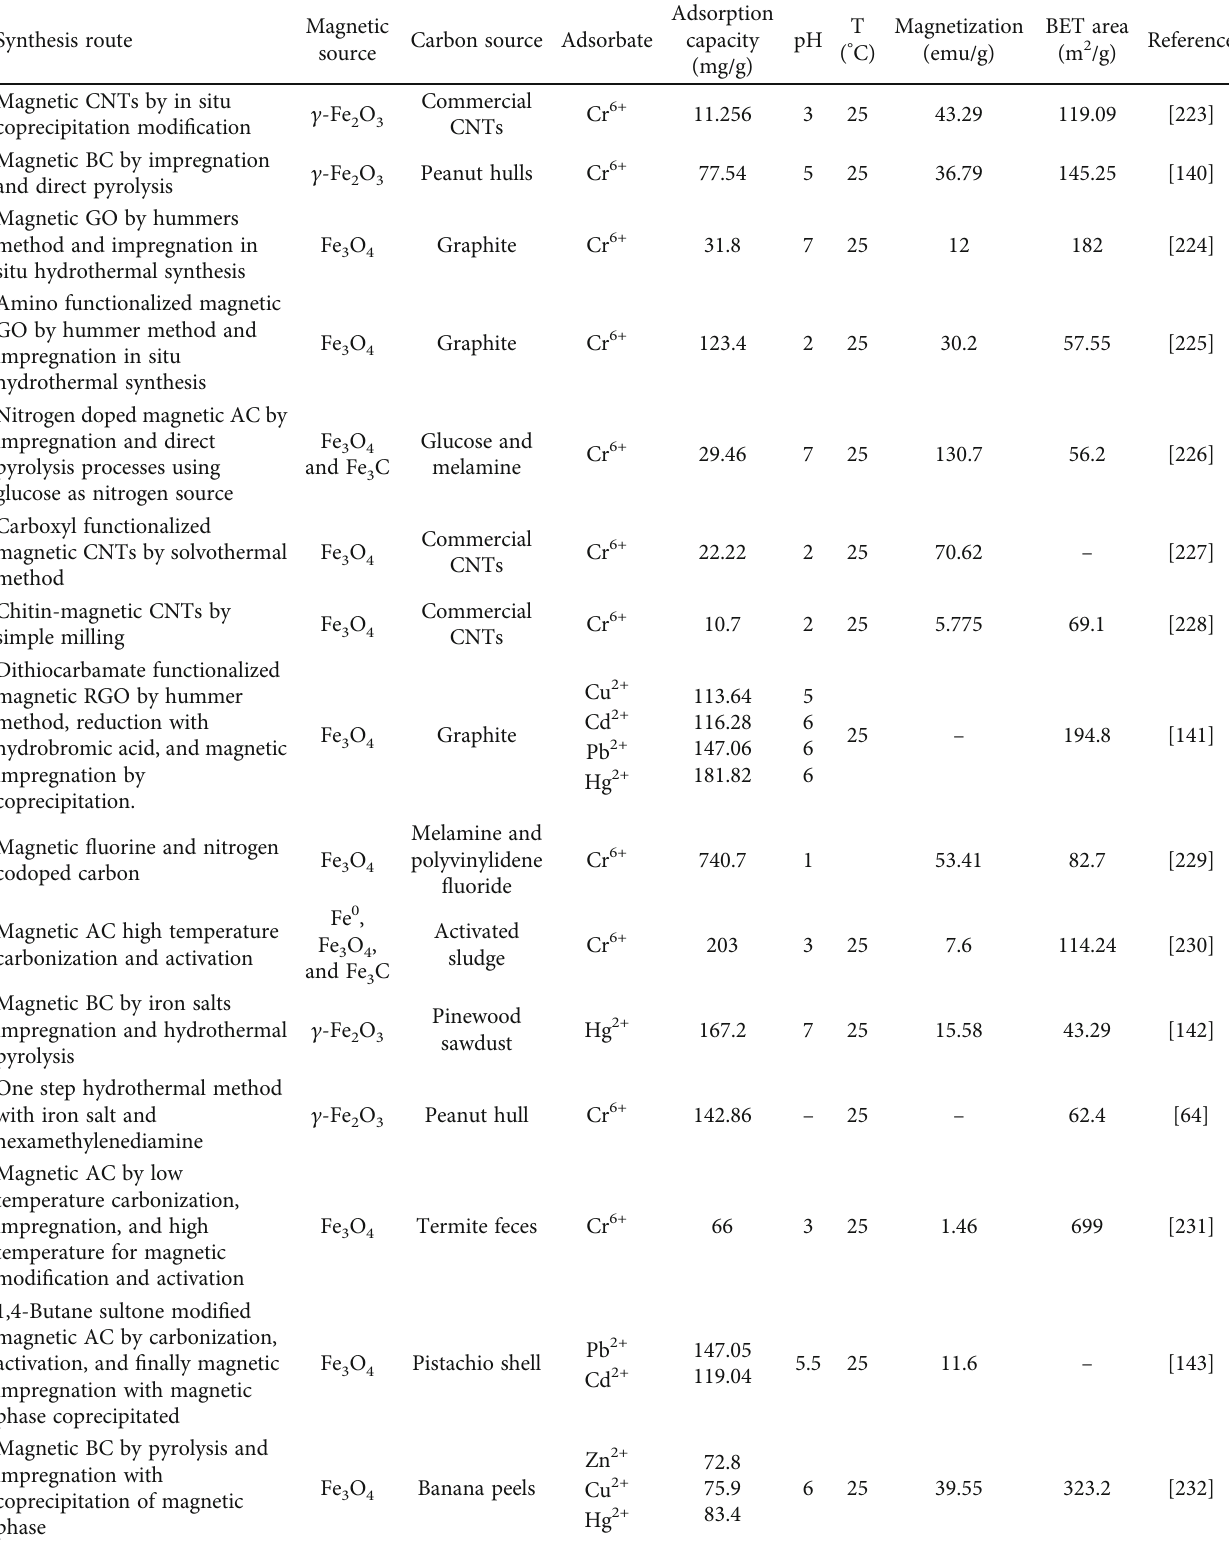
Table 3: Removal of heavy metals from aqueous solution using magnetic carbon-based adsorbents: preparation, removal operating conditions, and adsorption